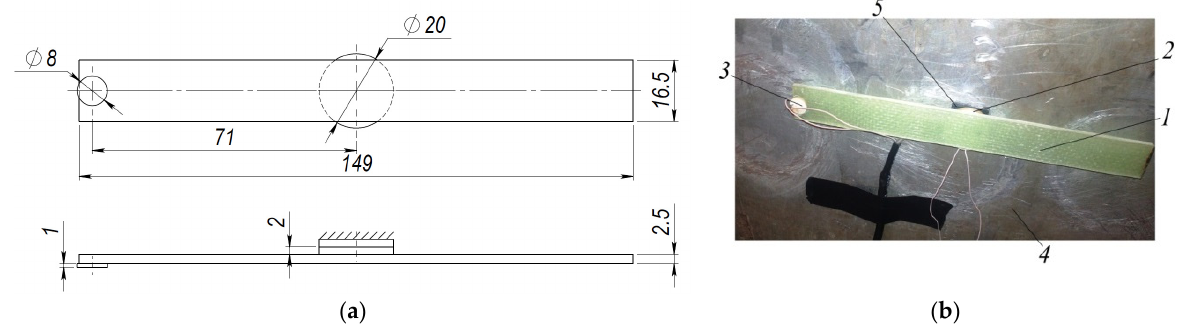
Figure 6. Test setup of the composite plate without defect: ( a ) Dimensions of the composite plate; ( b ) View of the test rig: 1—composite plate, 2—disc-shaped piezoelectric transducer (as the actuator) for exciting the structure, 3—disc-shaped piezoelectric transducer for plate vibration measurement, 4—aluminum base, 5—soft material isolation layer between piezoelectric actuator and aluminum base.